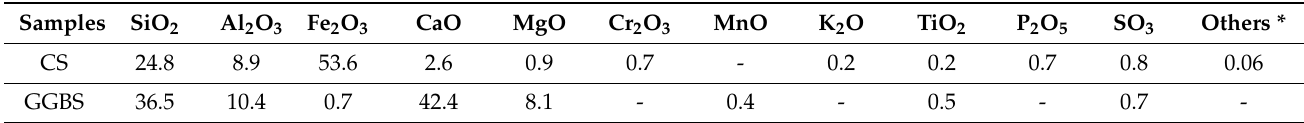
Figure 1. Particle size distribution of the CS per Blaine group, with the Blaine (cm 2 /g) indicated on the curves. Table 1. Normalized chemical composition in wt% by XRF analyses for CS. * includes small amounts that are <0.1 wt%. GGBS is according to the technical datasheet of Ecocem (www.ecocem.ie, accessed on 1 June